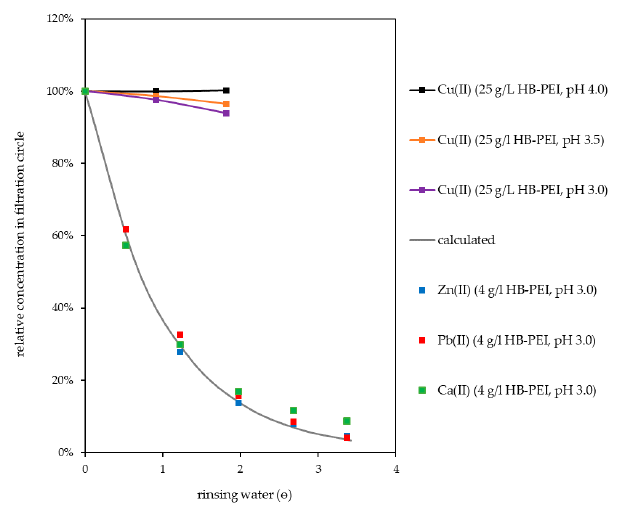
Figure 7. Rinsing of filtration circuit with water.